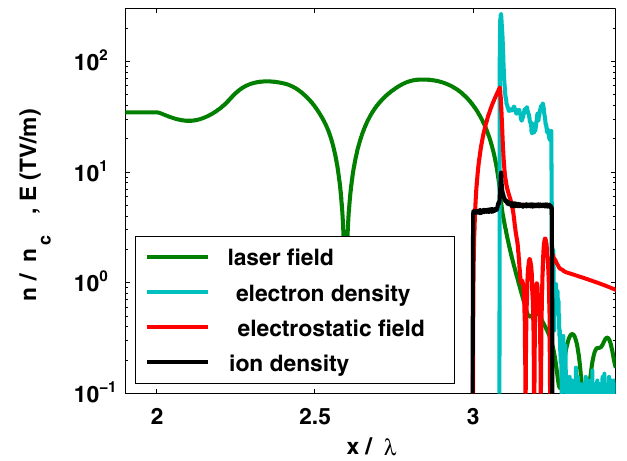
FIG. 3. (Color) Snapshot of the electric field, j ~E j , and the densities of electrons and ions taken from the 1D3V PIC simu- lation. The 80 fs long (a rectangular temporal envelope) CP laser pulse with the wavelength of 800 nm and the intensity of 3 : 5 (cid:2) 10 20 W = cm 2 is normally incident (from the left) on the ultrathin (cid:3) 5 : 25 (cid:2) 10 22 cm (cid:4) 3 ) fully ionized car- (200 nm) overdense ( n e bon foil. The time is one laser period after the beginning of the interaction. The densities are normalized to the critical